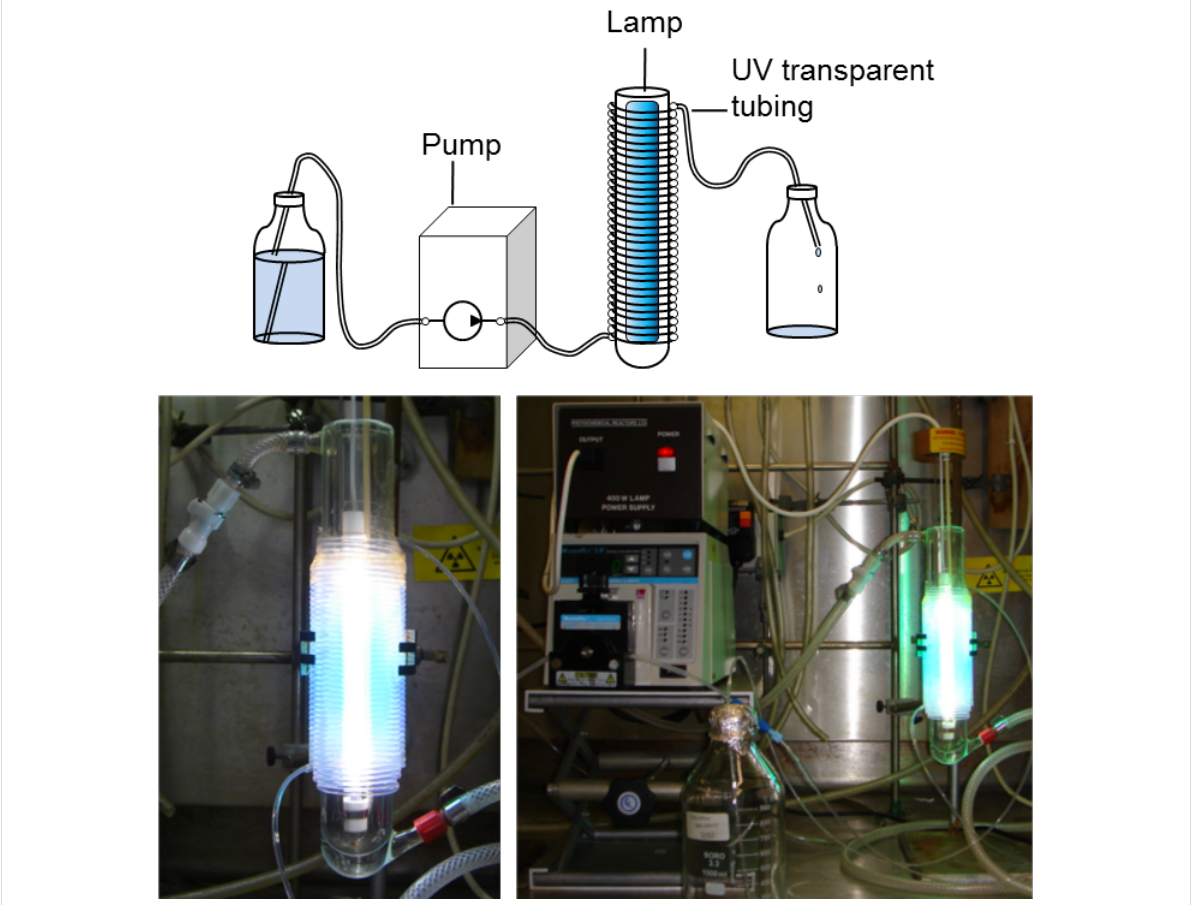
Figure 4: Schematic of a typical macroflow photochemical reactor (above) and images of the FEP photochemical flow reactor developed by Booker- Milburn and Berry [21].